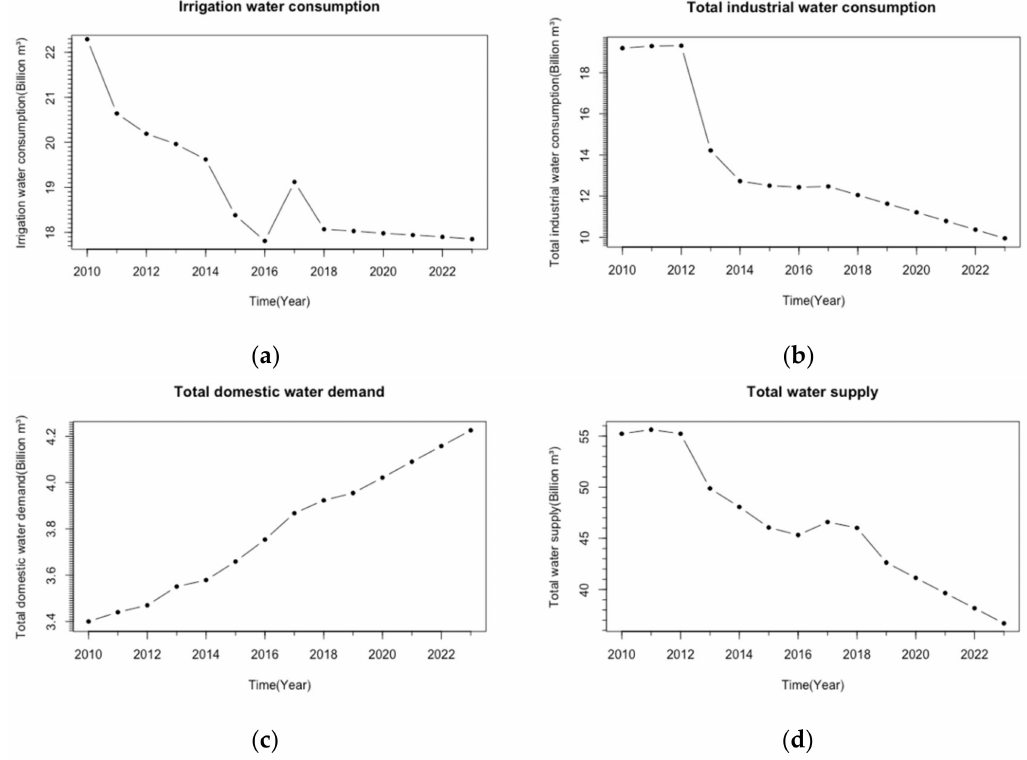
Figure 8. Scenario 1 simulation results: ( a ) Trend of irrigation water demand; ( b ) Trend of total industrial water consumption; ( c ) Trend of total domestic water demand; ( d ) Trend of total water